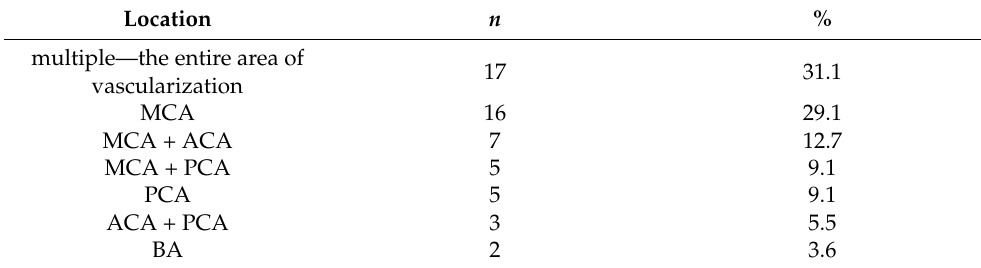
Table 3. Location of brain